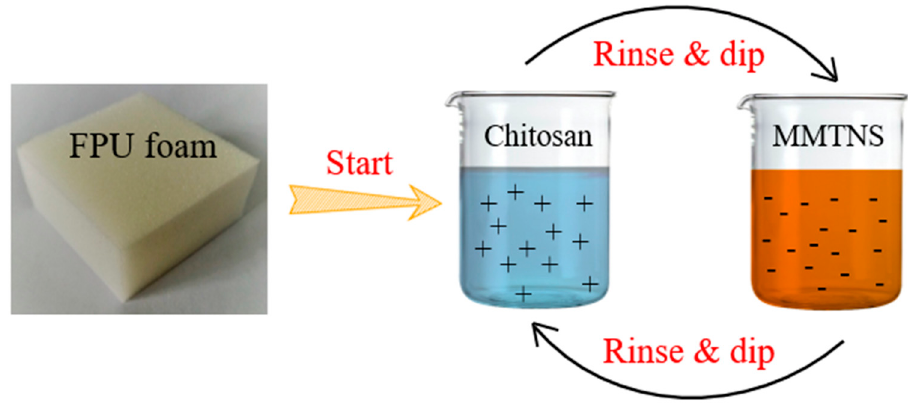
Figure 1. Schematic diagram of layer-by-layer (LbL) assembly on flexible polyurethane (FPU) foam using chitosan and montmorillonite nanosheets (MMTNS).